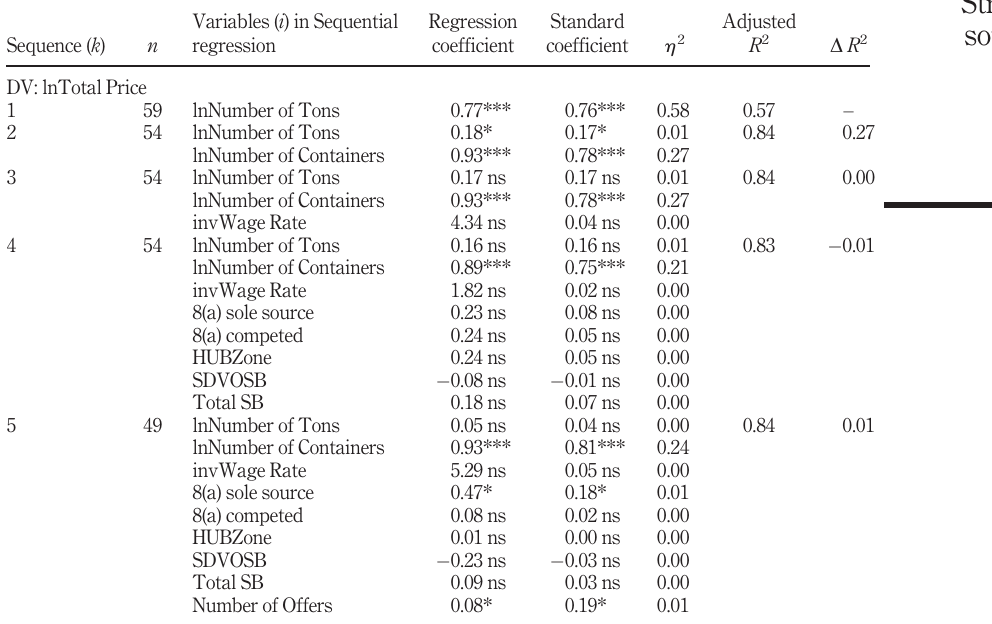
Table IV. Sequential regression